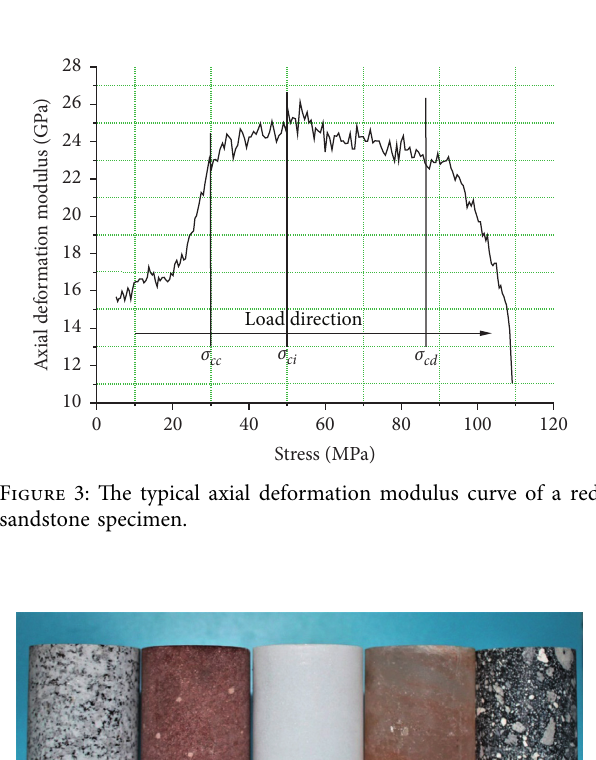
Figure 2: Typtical stress-strain curves of red sandstone specimens [12].